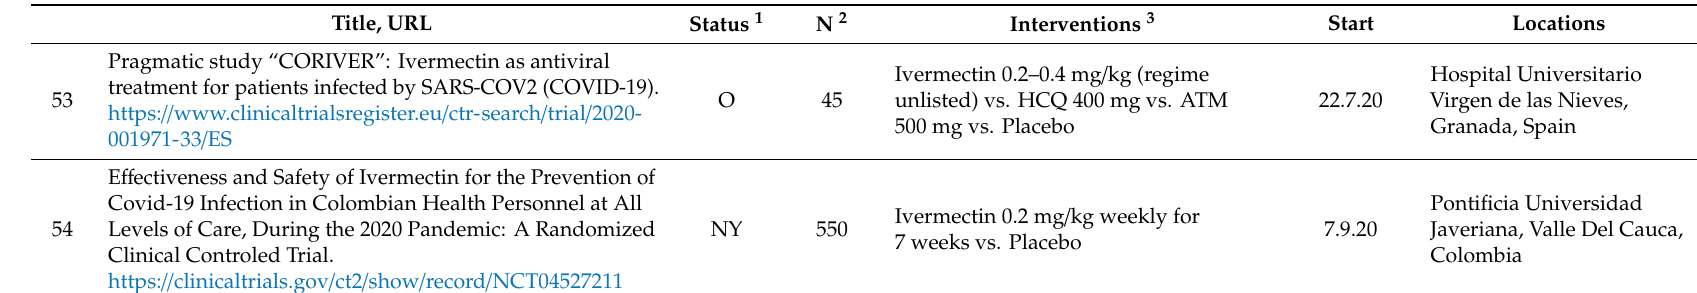
E ff ectiveness and Safety of Ivermectin for the Prevention